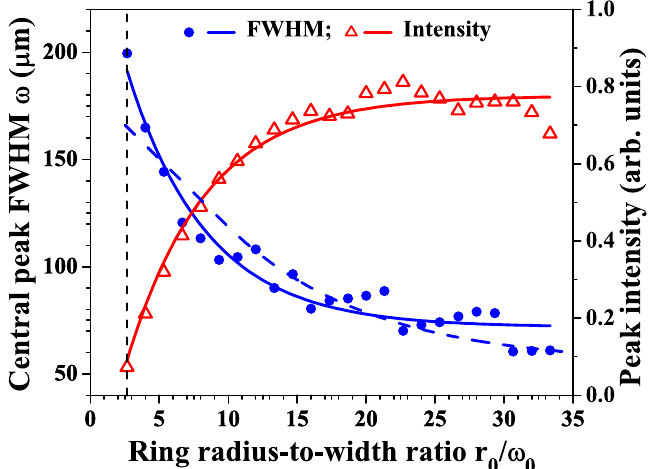
Figure 4. Blue dots/solid line and left scale: Experimental dependence of the full width at half maximum (FWHM) of the central peak of the zeroth-order GBB on the radius-to-width ratio r 0 /ω 0 of the bright ring measured in the plane of the lens. Blue dashed curve - numerical result obtained using Eq. (10). Red triangles/ solid line and right scale: Central peak intensity vs. r 0 /ω 0 extracted from the same set of experimental data. The CCD camera is located 45 cm (12 Rayleigh diffraction lengths z R of the focused pure Gaussian beam) behind the focus of the